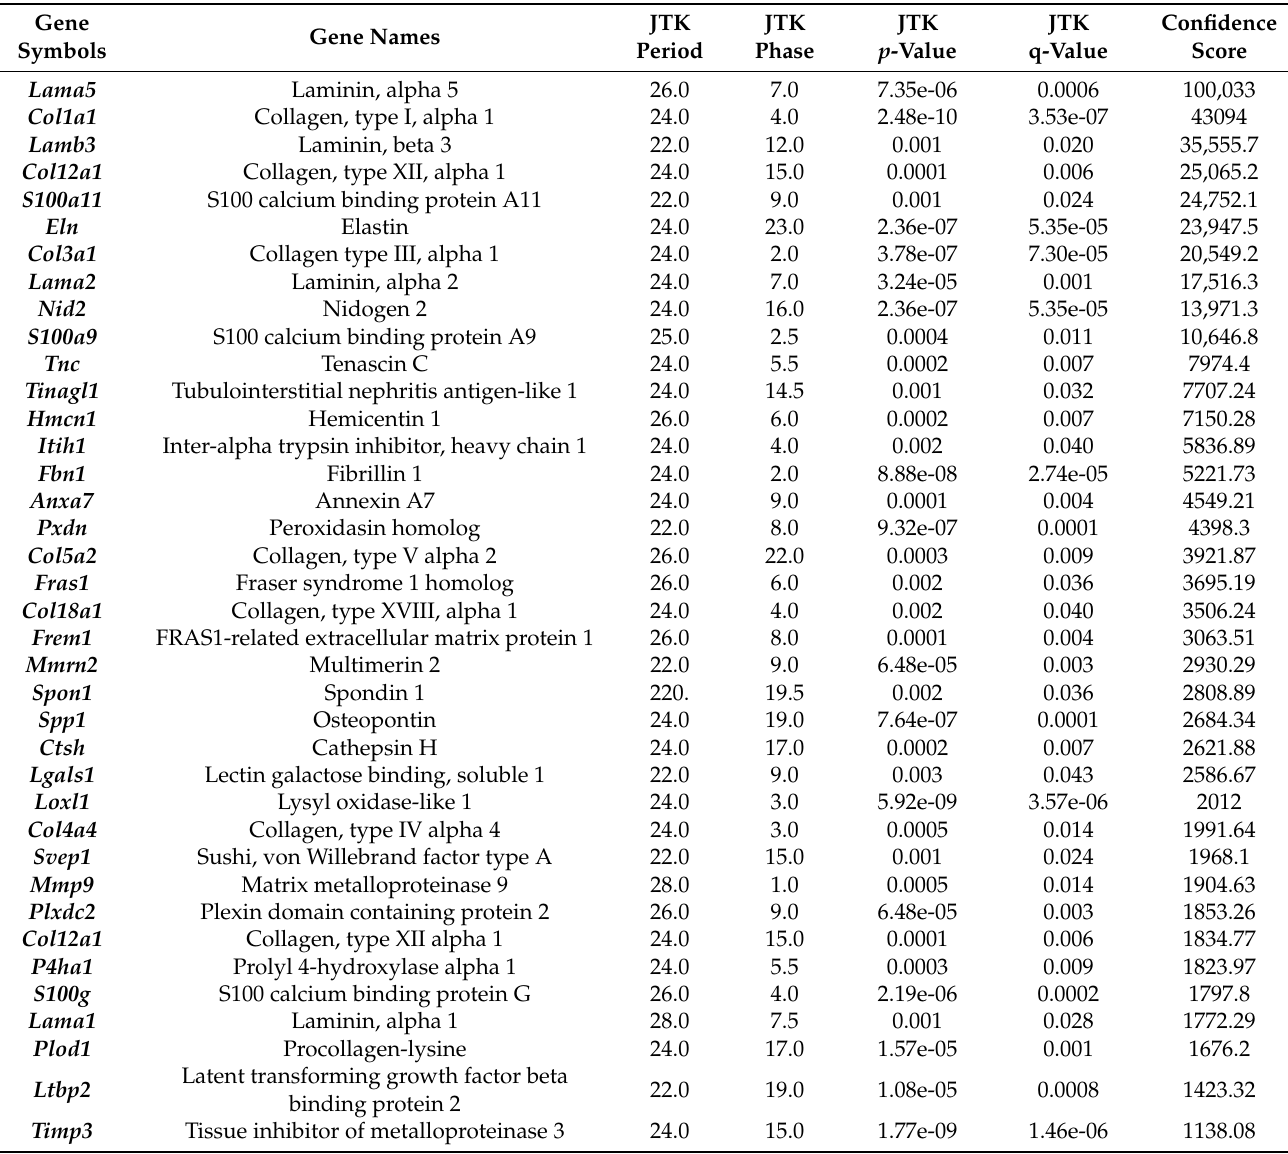
Table 1. Rhythmic expression of mouse ECM and ECM-associated genes highly expressed in lung fibrosis